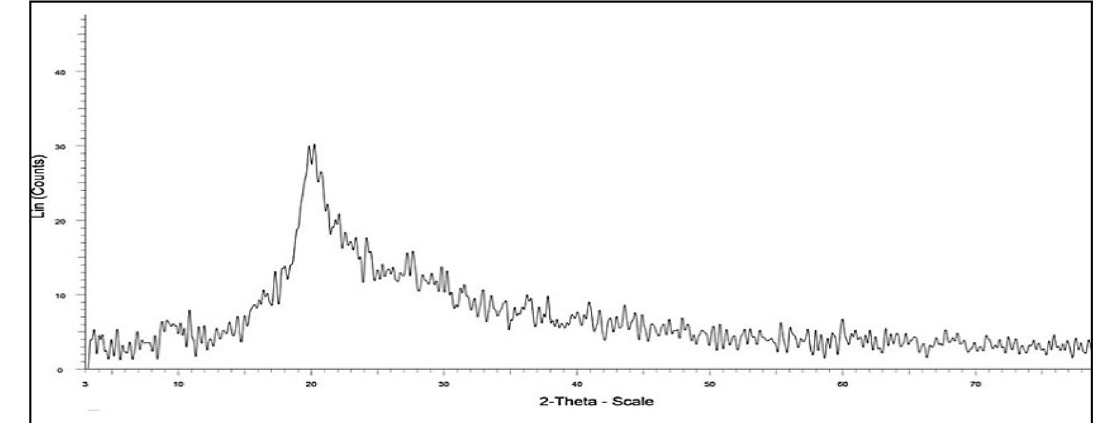
Figure 6. XRD pattern of chitosan.